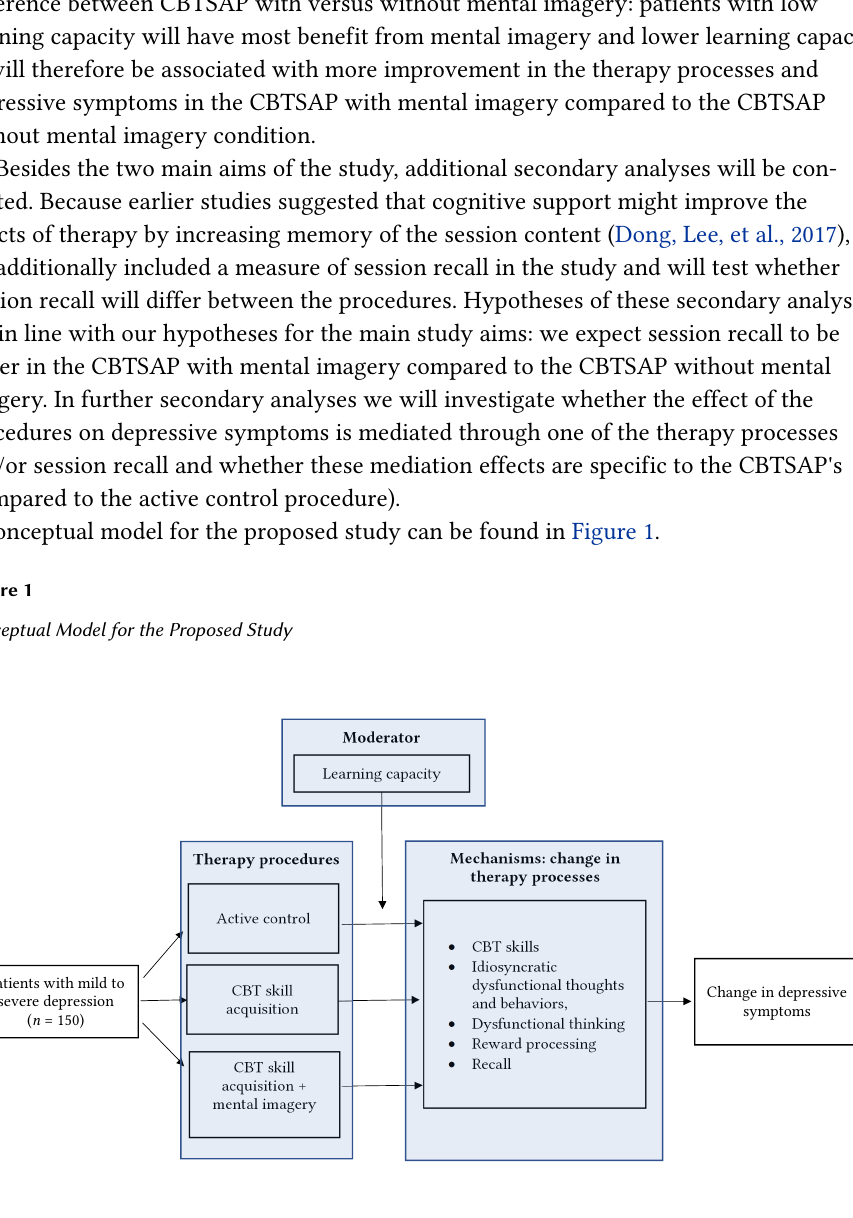
Change in depressive symptoms